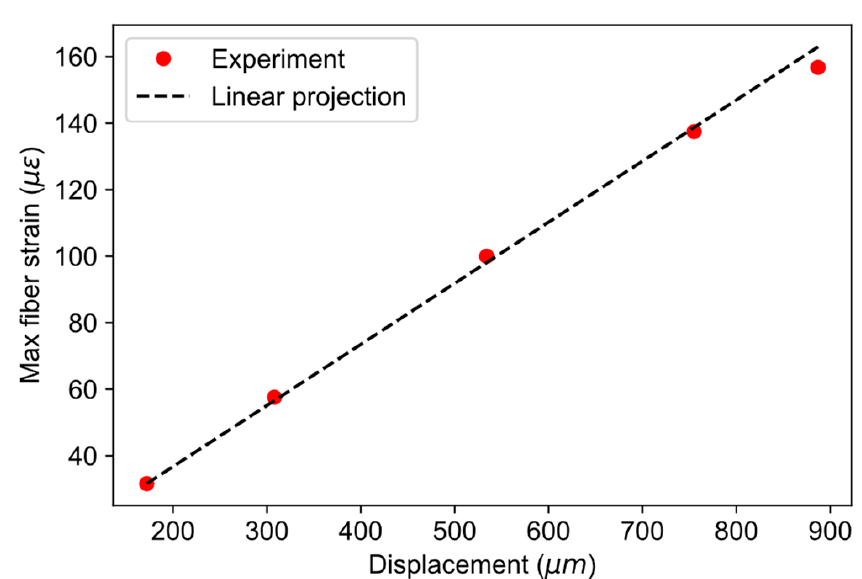
Figure 9. Response of fiber strains on applied displacement to the pipe.